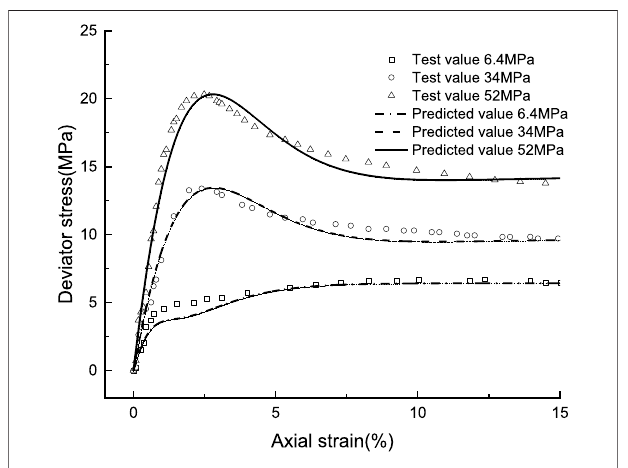
FIGURE 3 | Effective stress paths and model prediction results of undrained compression tests on dense Cambria sandy soil.